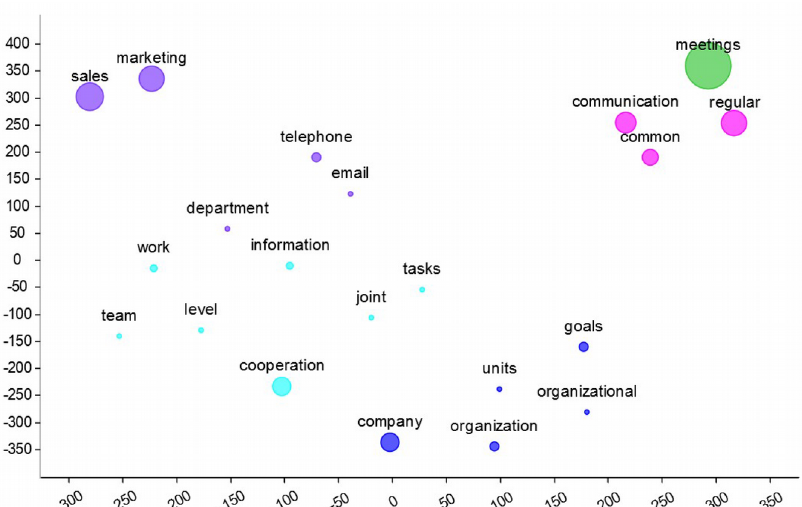
Figure 12. t-SNE generated clusters for the answers to Question 3, 5000 iterations (Own editing using www.voyant.tools.org